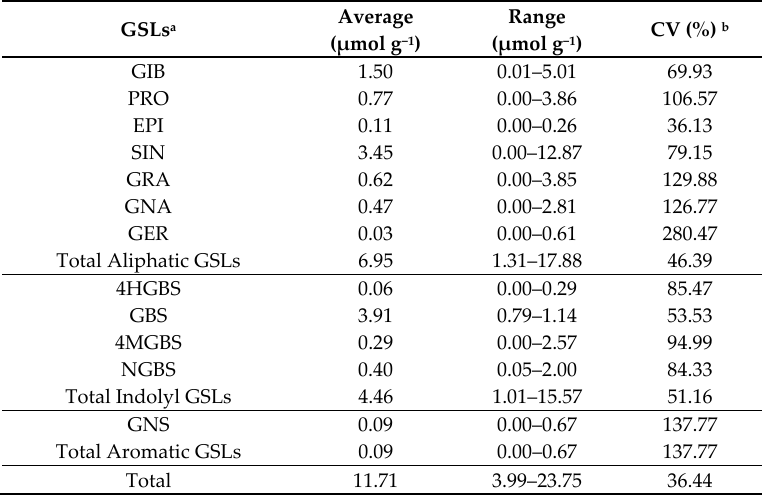
Table 2. The variation of glucosinolates in cabbage heads from 146